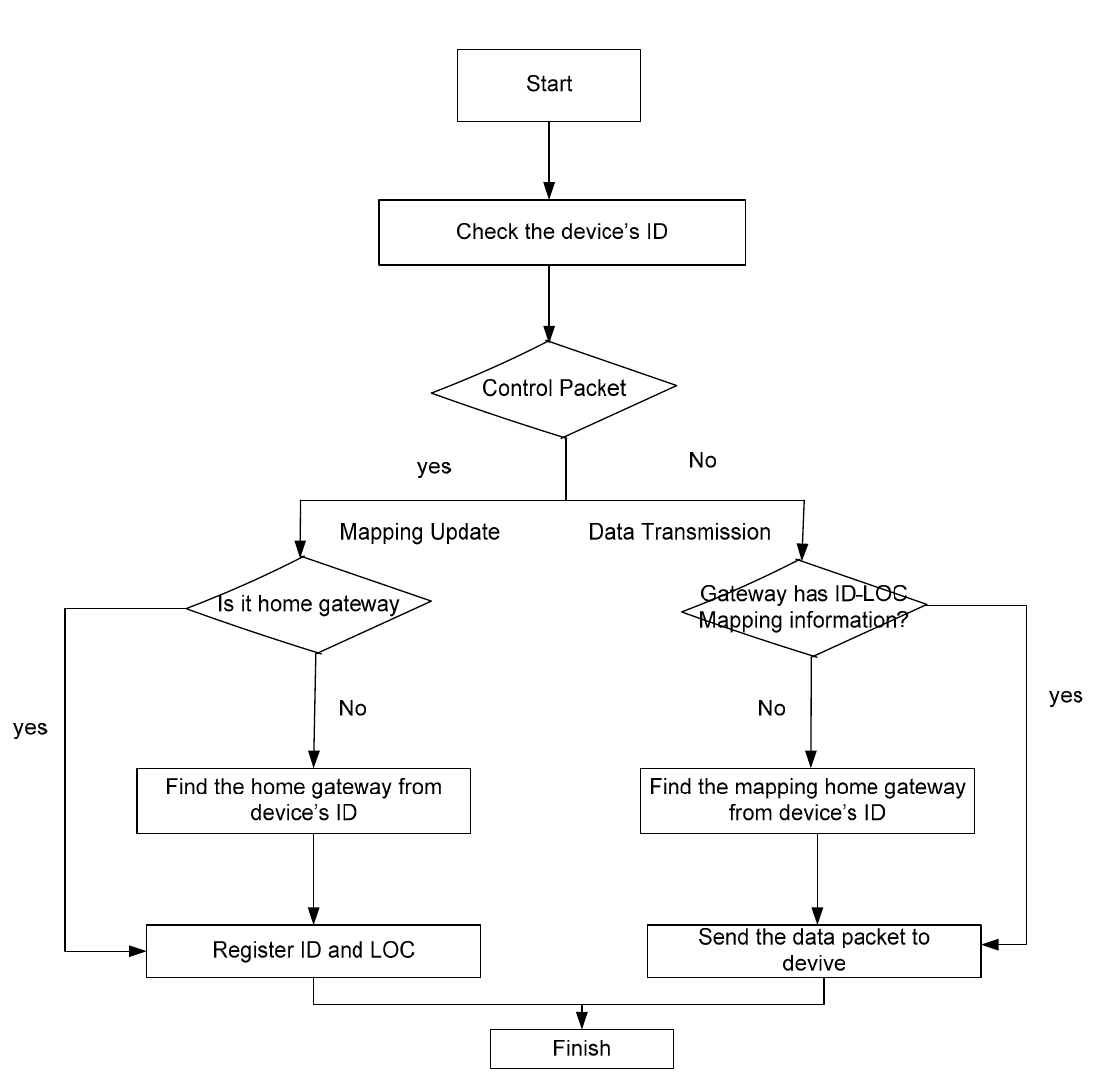
Figure 28. Algorithm at GW for mapping management and data transmission.